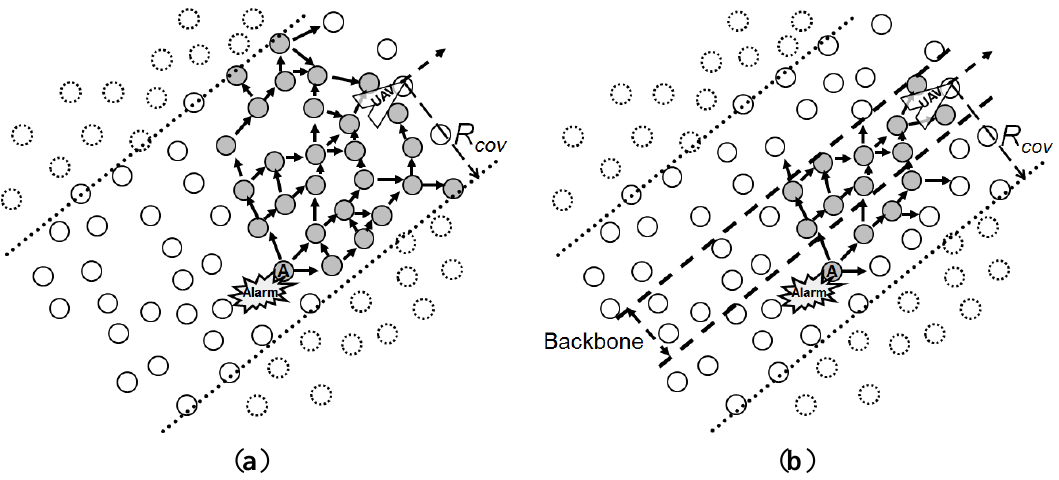
Figure 7. Alarm forwarding inside the pheromone trail: ( a ) Trail-follow without backbone; ( b ) Trail-follow with backbone, showing that a smaller number of nodes are involved in the alarm message